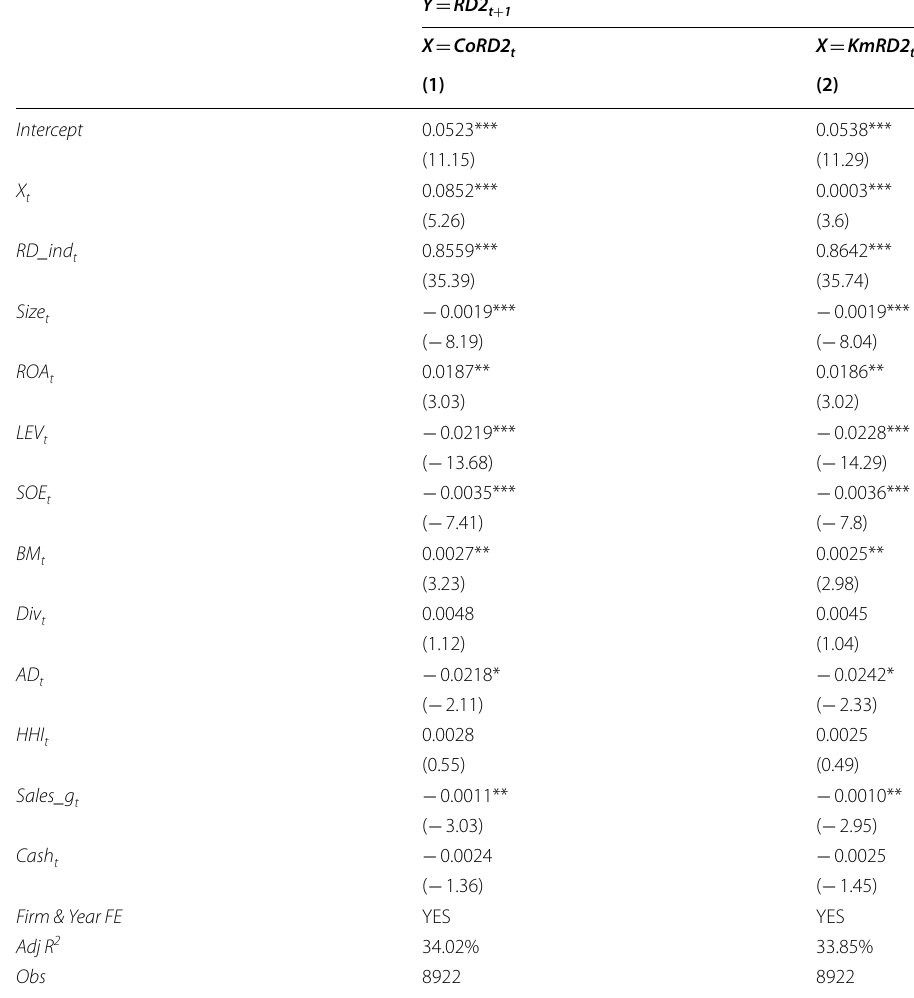
Table 6 Robustness test of alternative measures of